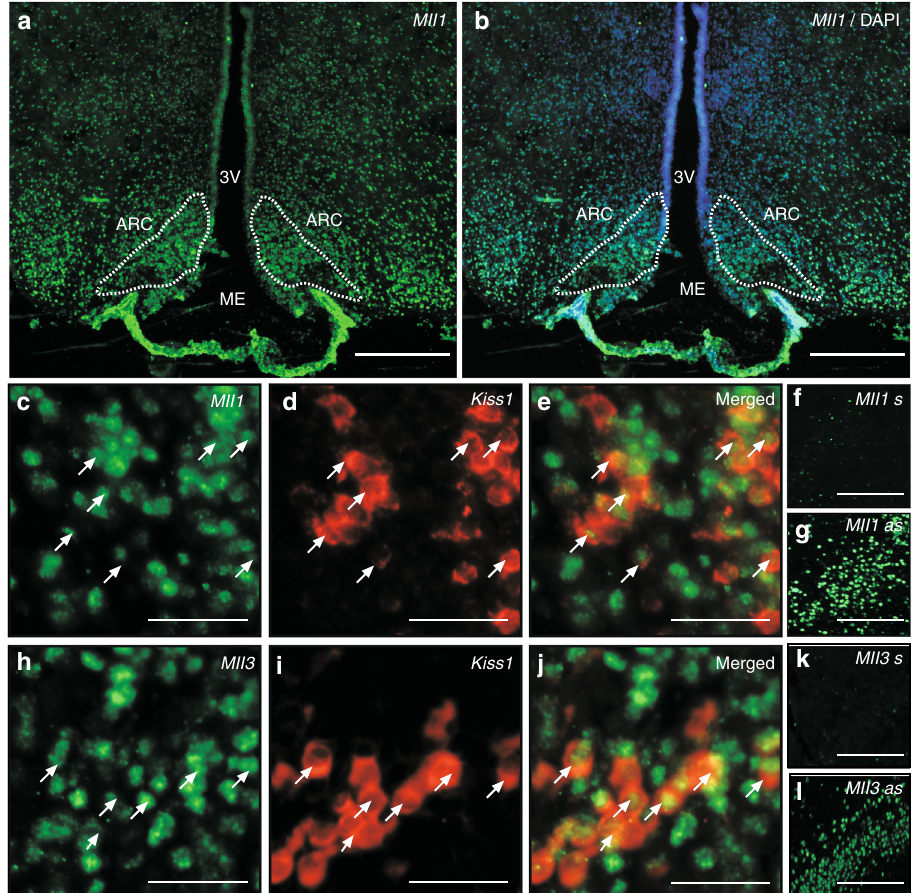
Fig. 2 Mll1 and Mll3 mRNA transcripts in KNDy neurons of late juvenile female rats. a , b Abundance of Mll1 mRNA transcripts (green color) in the arcuate nucleus (ARC, dotted line) region of the MBH, as determined by FISH. 3V, third ventricle; ME, median eminence. Bars, 500 µ m. c – e KNDy neurons of the ARC contain Mll1 mRNA as determined by double FISH ( Kiss1 mRNA, red; Mll1 mRNA, green). h – j KNDy neurons also contain Mll3 mRNA. Bars, 100 µ m. f , g Lack of hybridization in sections incubated with a sense Mll1 RNA probe. k , l Lack of hybridization in sections incubated with a sense Mll3 RNA probe. Bars, 200 µ m. s = sense; as =